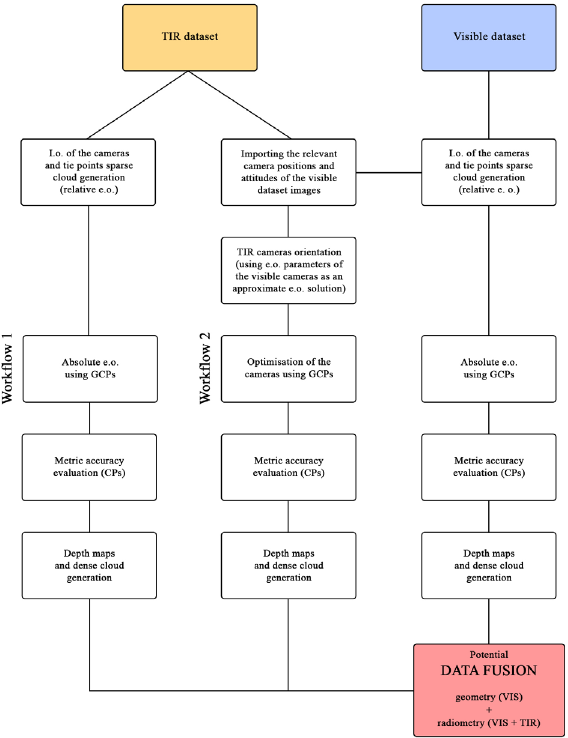
Figure 6 . Flowchart of the followed workflows.